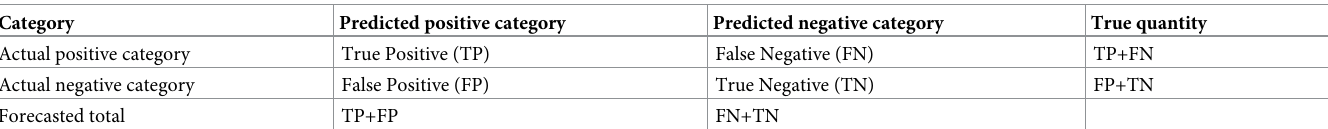
prediction values in Table 3, four single evaluation indicators of the classification oversampling